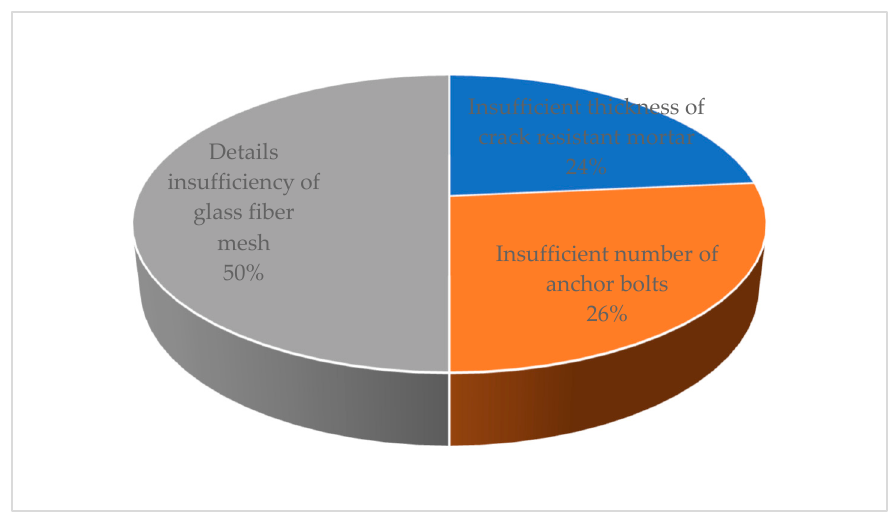
Figure 13. Proportion of detail insufficiencies of façade.